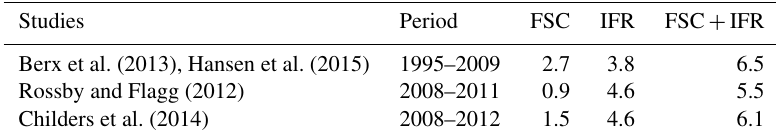
Table 5. Volume transport (in Sv) of Atlantic water flow through the Faroe–Shetland Channel (FSC) and across the Iceland–Faroe Ridge (IFR) as determined by different methods. The estimates by Rossby and Flagg (2012) and by Childers et al. (2014) include a closed circulation on the Faroe Shelf (0.6Sv) and flow on the Scottish Shelf, which are not included in the estimates by Berx et al. (2013) and Hansen et al. (2015). Studies Period FSC IFR FSC + IFR Berx et al. (2013), Hansen et al.